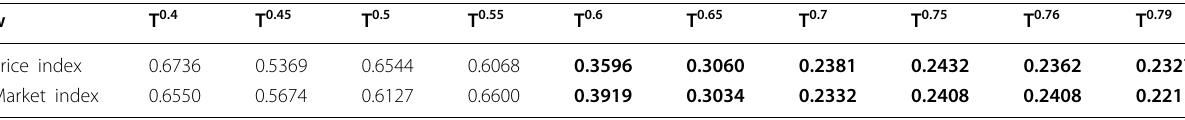
w and T are the bandwidth number and the total number of observations, respectively. Values in bold are those cases where the d estimates are significantly lower than 0.5